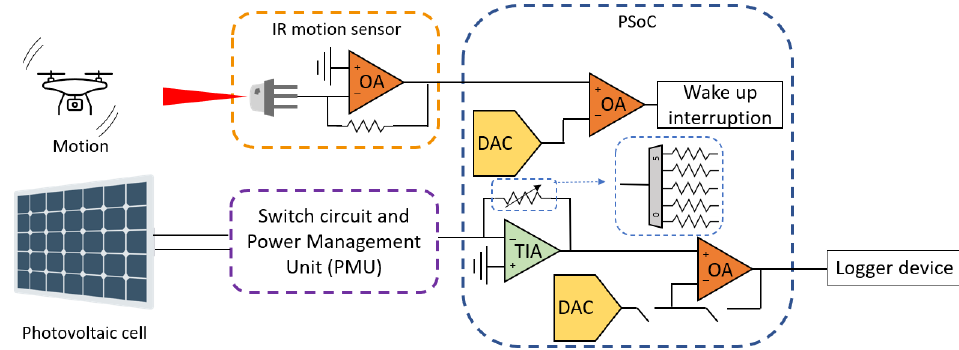
Figure 4. Illustration of the system design. IR: infrared; PSOC: programmable system on chip; DAC: digital-to-analog converter; TIA: transimpedance amplifier; OA: operational amplifier.